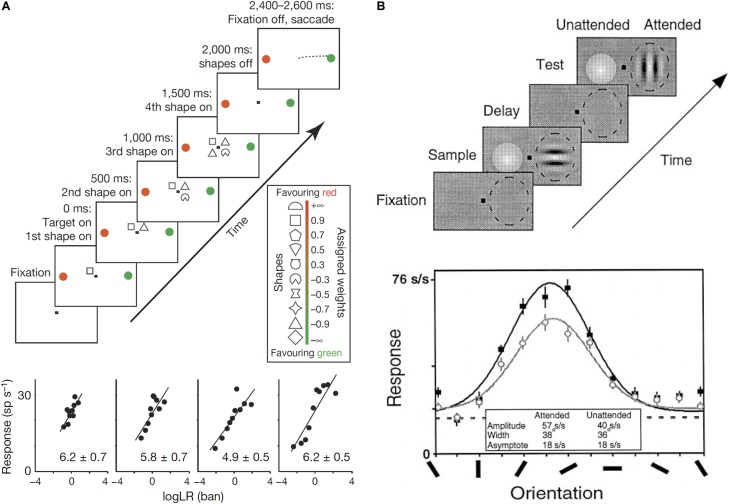
(A) Log-probability coding. The task sequence used by Yang and Shadlen (2007) (top). After four shapes were presented sequentially around the central fixation point, the monkey made a saccade to either the red or green choice target. One of the choice targets was in the response field of the recorded neuron. The shapes were selected randomly in each trial from a set of 10 shapes, which are associated with different weights (log likelihood ratio, log LR), for preferred target location (inset). The reward was determined probabilistically by summing the log LR associated with the four shapes. Firing rate is linearly correlated with the summed log LR (bottom). (B) Gain modulation by attention. Sequence of the delayed match-to-sample task used by McAdams and Maunsell (1999) (top). While the monkey was gazing at the fixation point and holding a lever, a Gabor stimulus was presented in the receptive field of a recorded neuron (dashed oval) with a colored Gaussian stimulus outside the receptive field during the sampling period. Whereas the monkey was required to pay attention to the orientation of the Gabor pattern in the attended mode, it was required to pay attention to the color of the Gaussian one in the unattended mode. After the delay period with no stimulus except for the fixation point, a Gabor and a Gaussian appeared again and the monkey had to report whether the test stimulus at the attended location matched the sample stimulus during the test period by releasing (match case), or maintaining, hold of the lever. Tuning curves of one V4 neuron for the attended mode (solid symbols) and the unattended mode (open symbols). The response amplitude significantly increased in the attended mode relative to the unattended mode without significant changes in the width or base line activity.